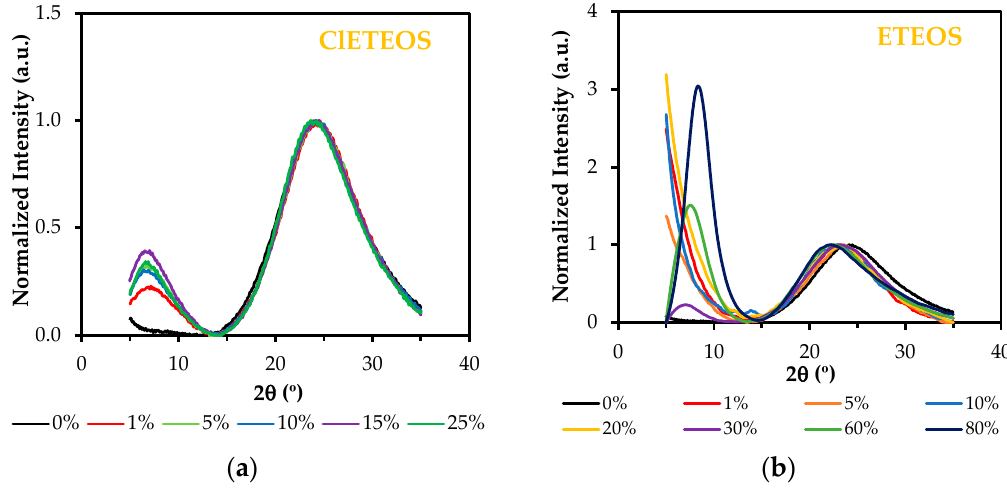
Figure 4. X-ray diffraction spectra of the hybrid xerogels at different molar percentages (normalized with respect to the band 2 θ ~4°: ( a ) ClETEOS:TEOS, and ( b ) ETEOS:TEOS.